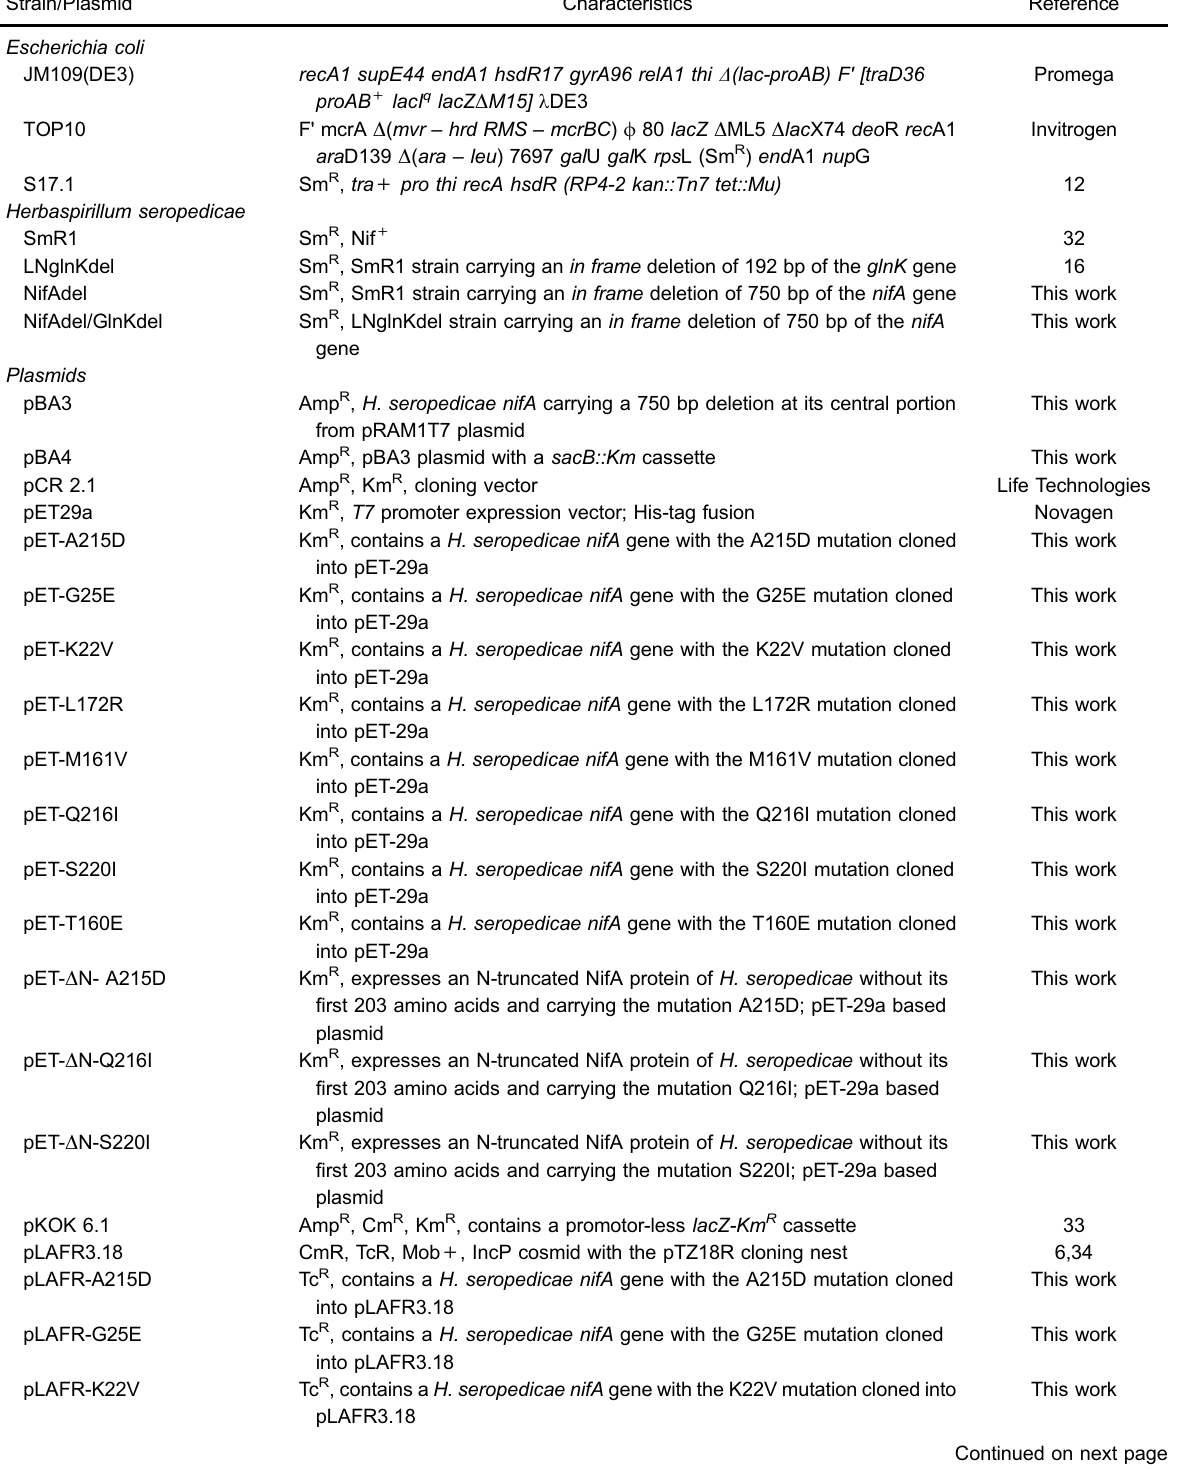
Table 1. Bacterial strains and plasmids.